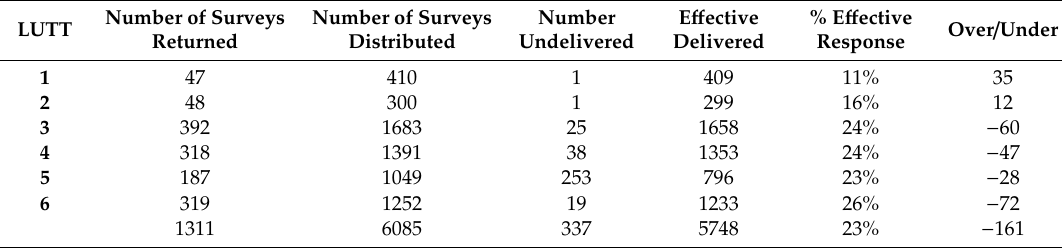
Table A1. Response Rate, Full Survey by LUTT.